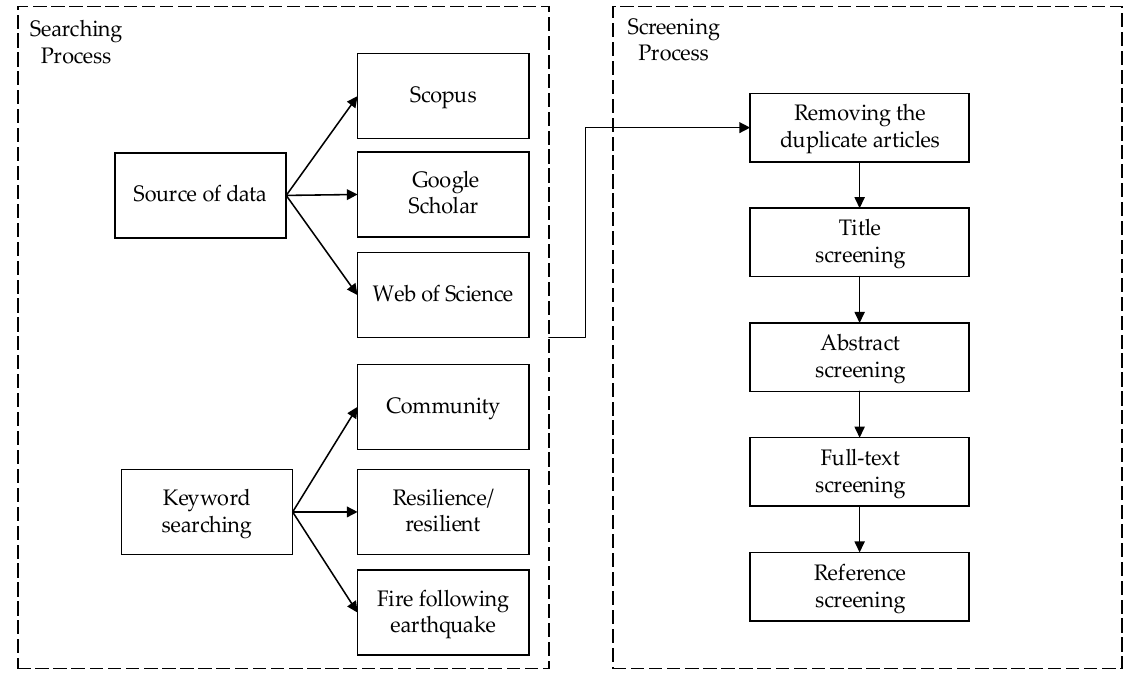
Figure 1. Flowchart of the systematic literature review. Table 1. Indicators on community resilience adapted to FFE.